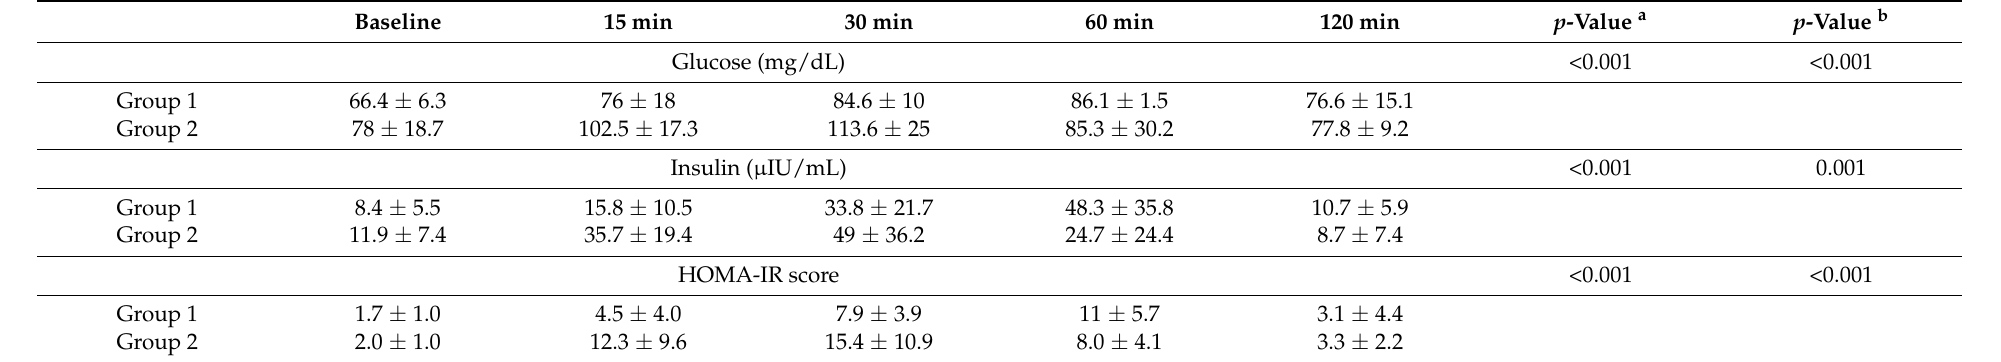
Table 2. Serum glucose, insulin, HOMA-IR (homeostatic model assessment) score, FGF-21 (fibroblast growth factor), copeptin, osmolarity, sodium, BUN (blood urea nitrogen), lactate, uric acid, and phosphate levels after the ingestion of 500 mL of apple juice over